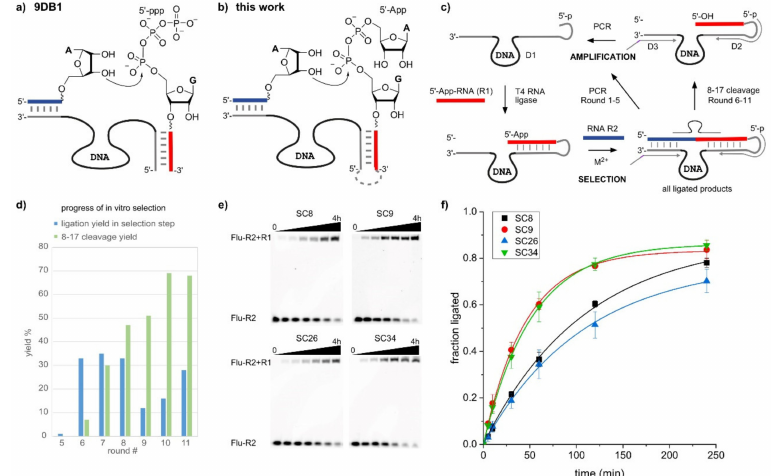
Figure 1. ( a ) RNA ligation reaction catalyzed by 9DB1, using a 5 (cid:48) -triphosphate donor RNA. ( b )